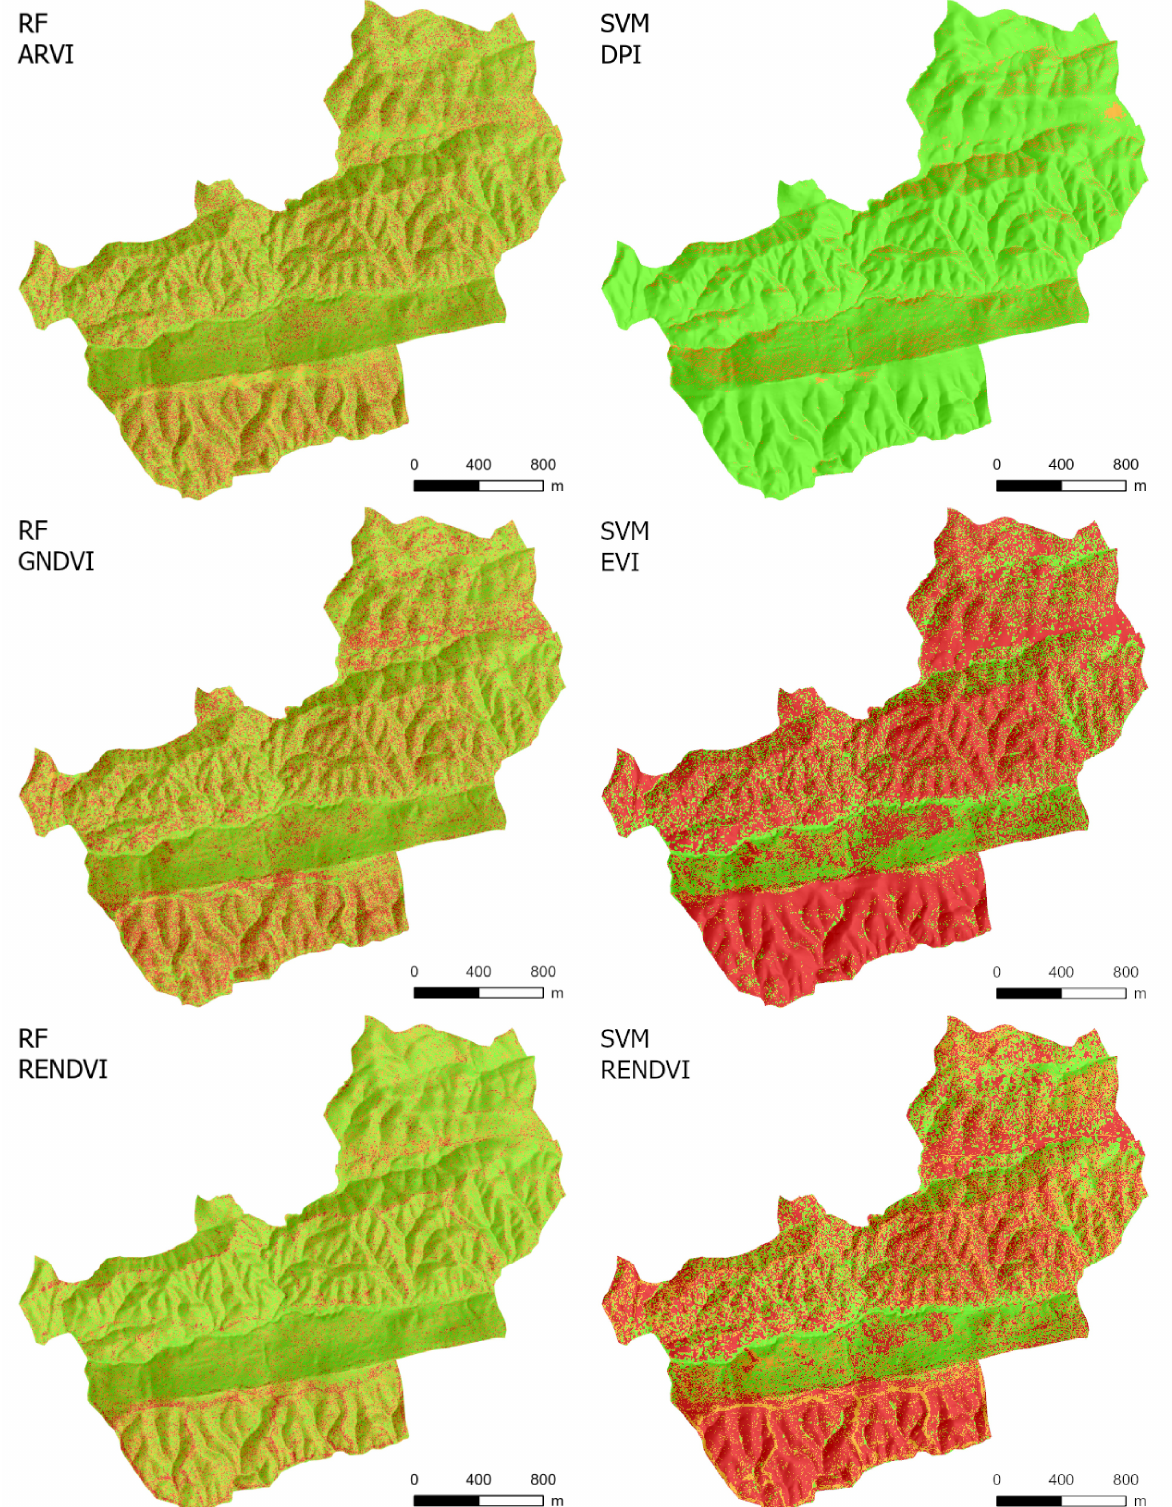
Figure 2. Maps of the classified raster data set of the entire dehesa. ARVI, GNDVI, and RENDVI with Random Forest classifier (left) and DPI, EVI, and RENDVI with Support Vector Machine classifier (right). Green, orange, and red indicate pixels classified as healthy, sick, and dead,